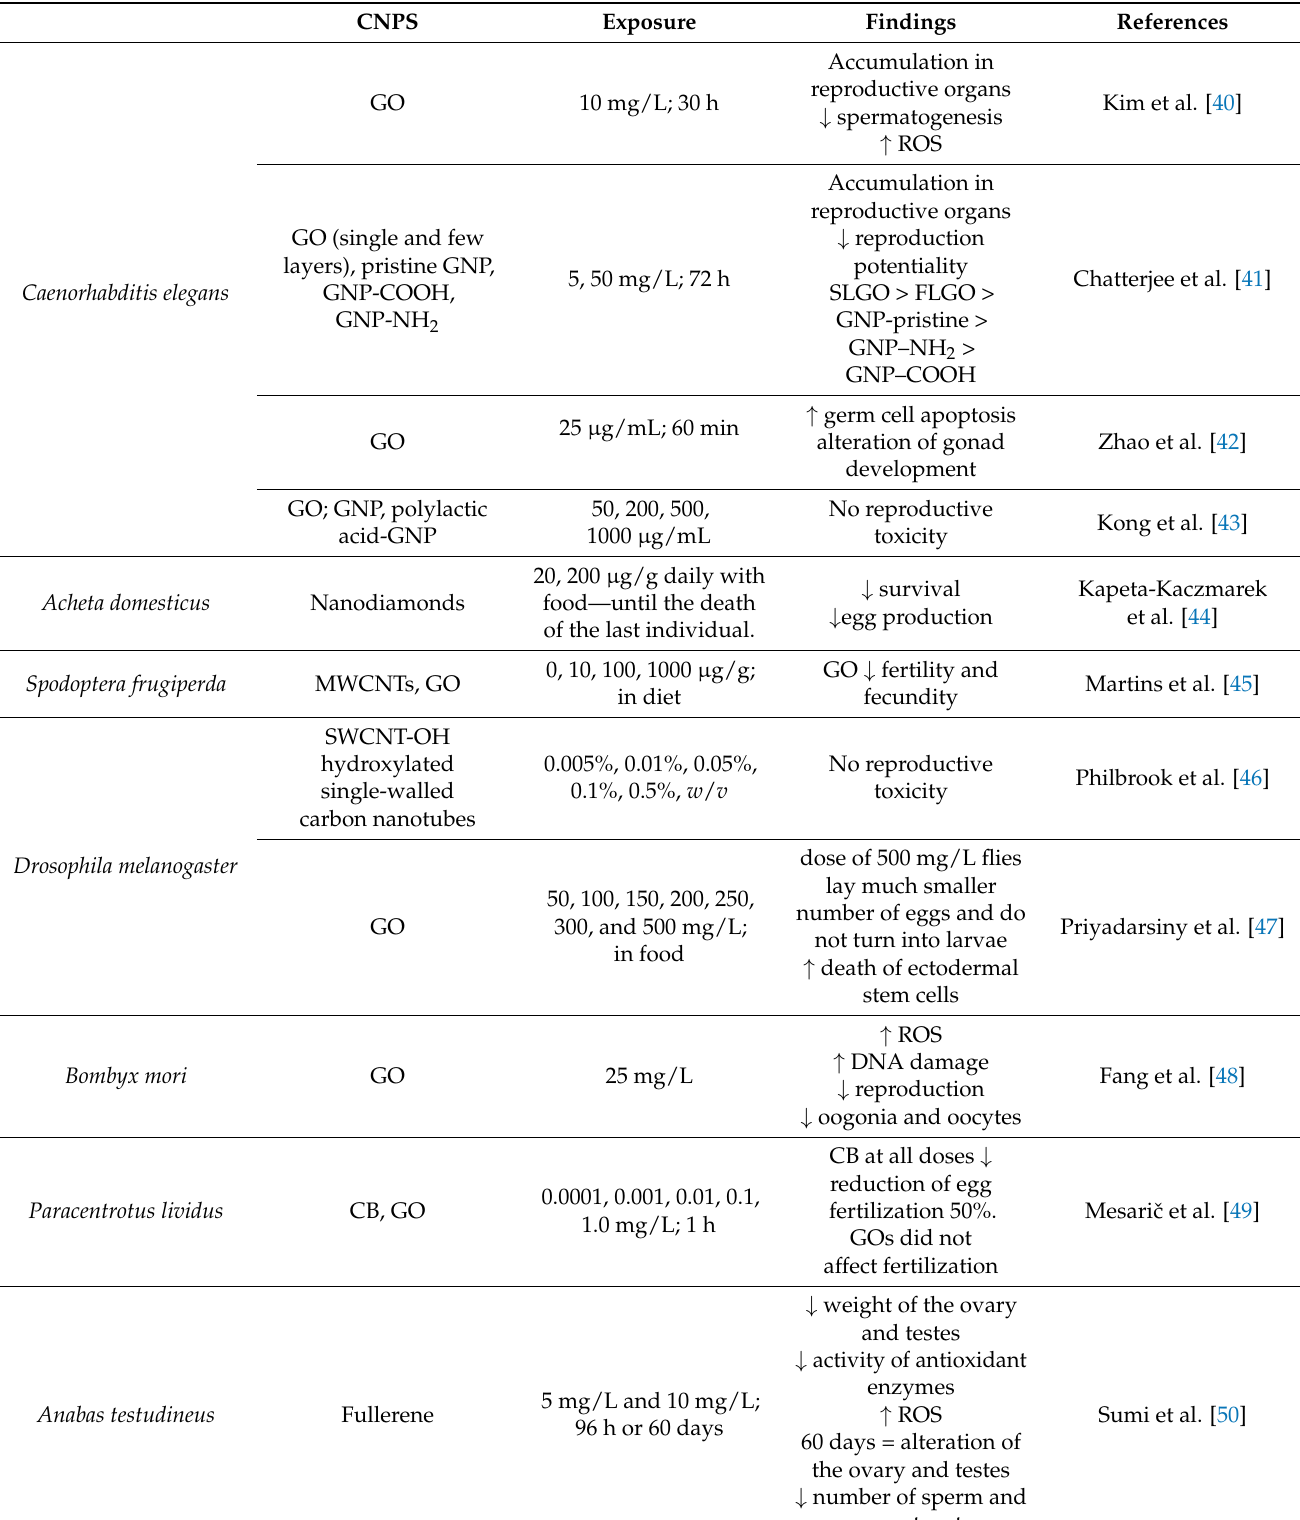
Table 1. Summary: in vivo